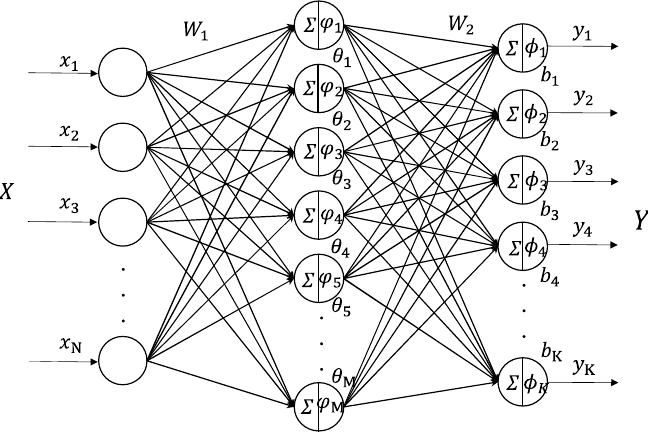
Figure 1. Structure diagram of typical BP neural network.